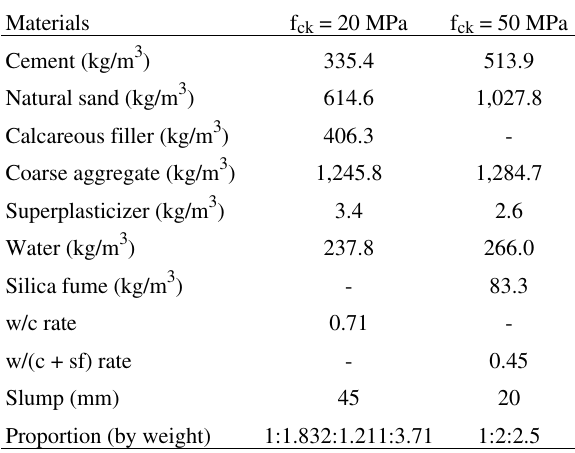
Table 1. Concrete mix